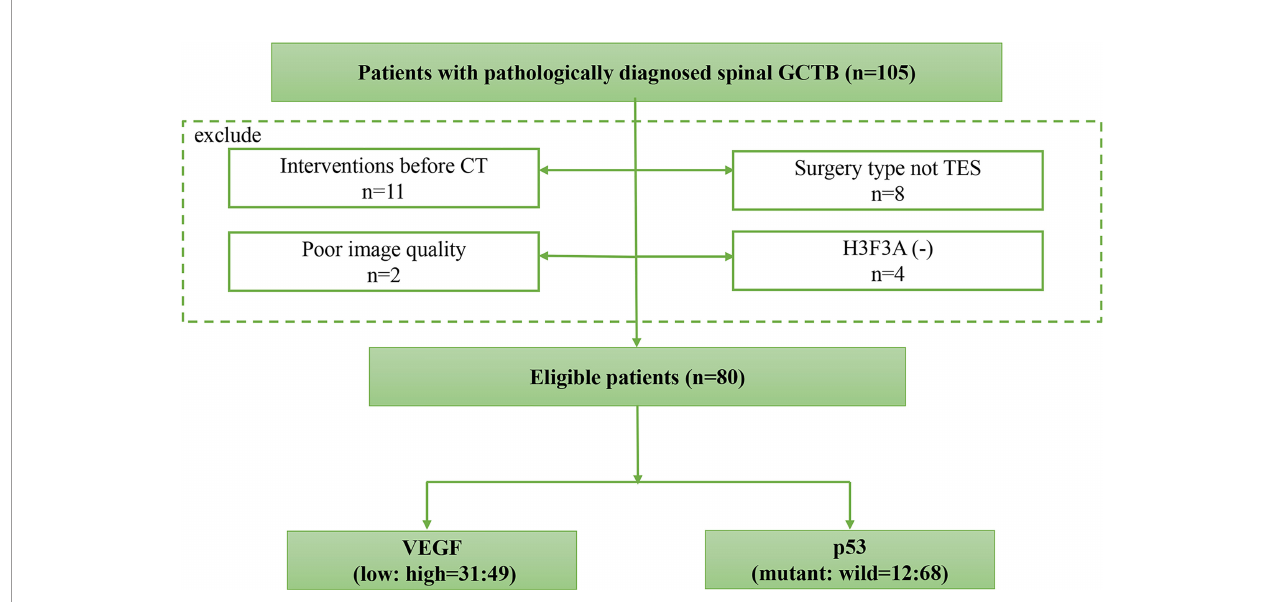
FIGURE 1 | The subject identi fi cation fl owchart. A total of 80 spinal GCTB cases with VEGF and p53 immunohistochemical staining results are